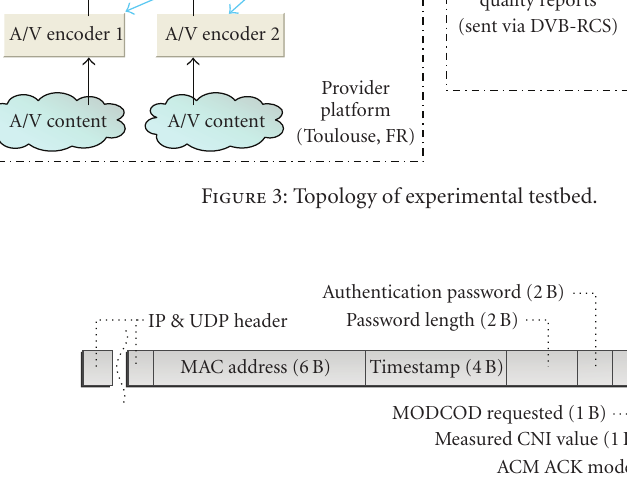
Figure 4: UDP packet destined to the SRMS and containing the C/ ( N + I )